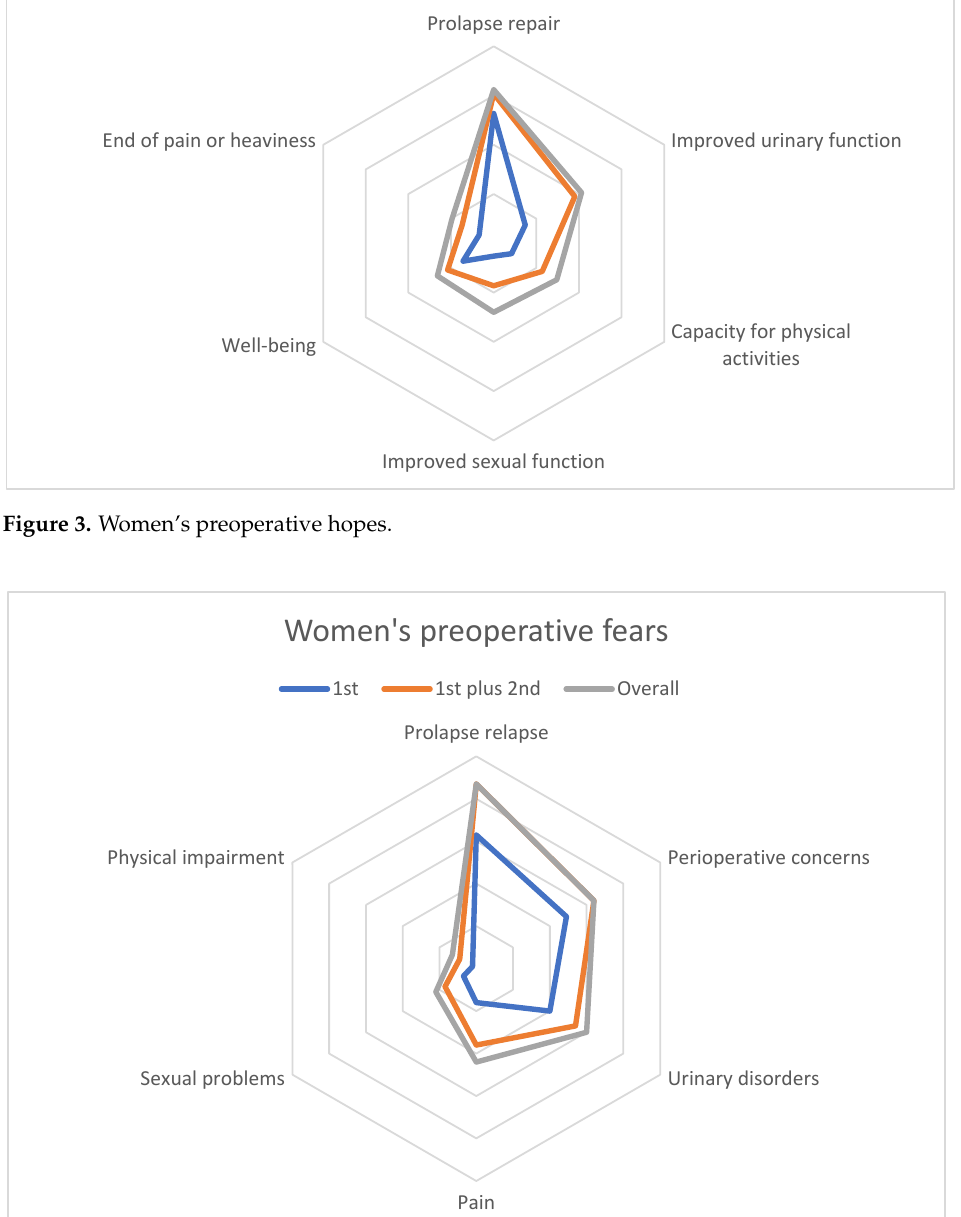
Figure 4. Women’s preoperative fears.